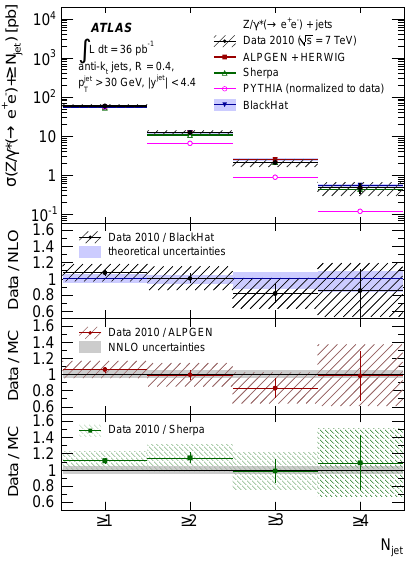
Fig. 1. Measured cross section for Z / γ ∗ ( e + e − ) + jets production → as a function of the inclusive jet multiplicity. In this and in fig- ures 2-4 the error bars indicate the statistical uncertainty and the dashed areas the statistical and systematic uncertainties added in quadrature. The measurements are compared to NLO pQCD pre- dictions from BlackHat and to MC predictions from ALPGEN, Sherpa and